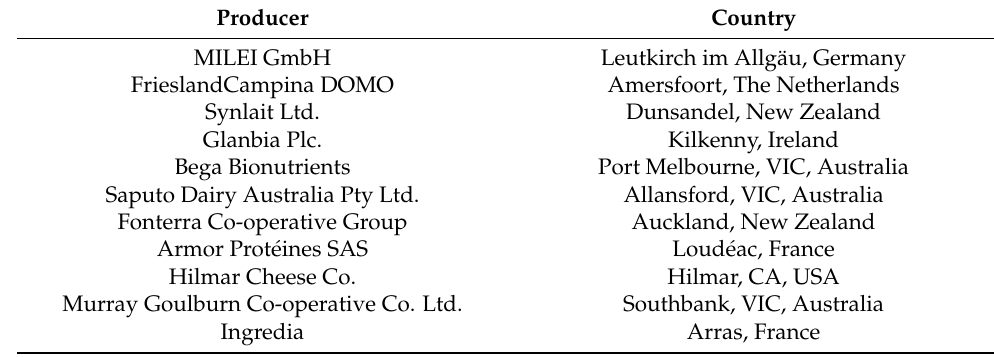
Table 4. Key lactoferrin producers around the world (own work based on [96]). Producer Country MILEI GmbH Synlait Ltd.